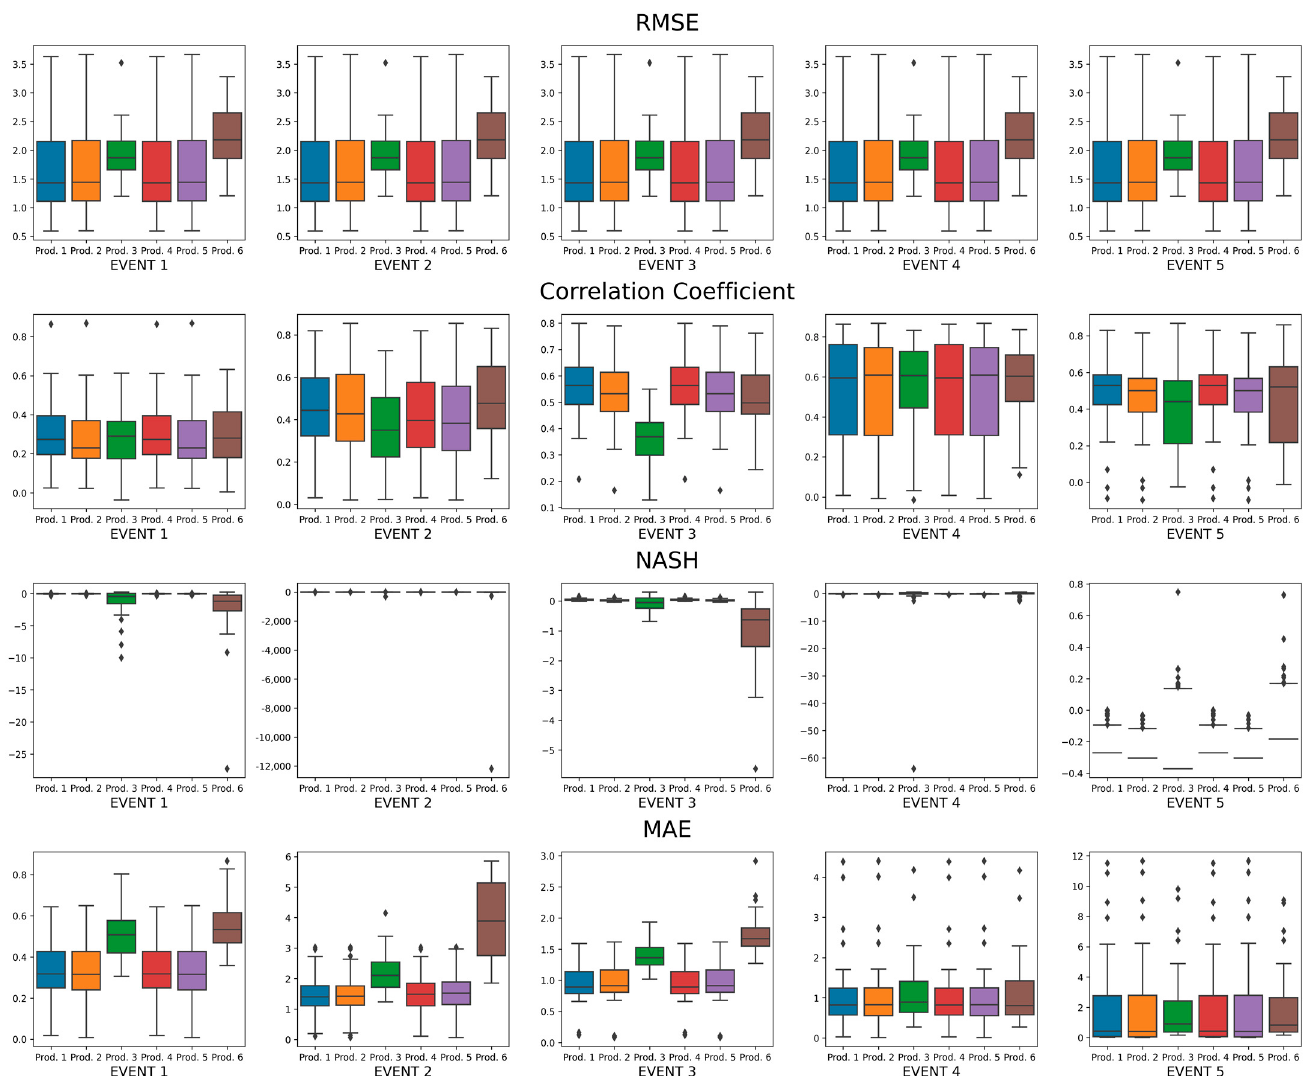
Figure 5. Statistical indices (RMSE, Pearson correction coefficient, Nash–Sutcliffe efficiency, and mean absolute error) of the comparisons for Events 1, 2, 3, 4, and 5 between rain gauge results and Guaratiba’s six S-band radar products using 𝑍 (cid:3035)(cid:2869) at radar pixels where rain gauges are located.